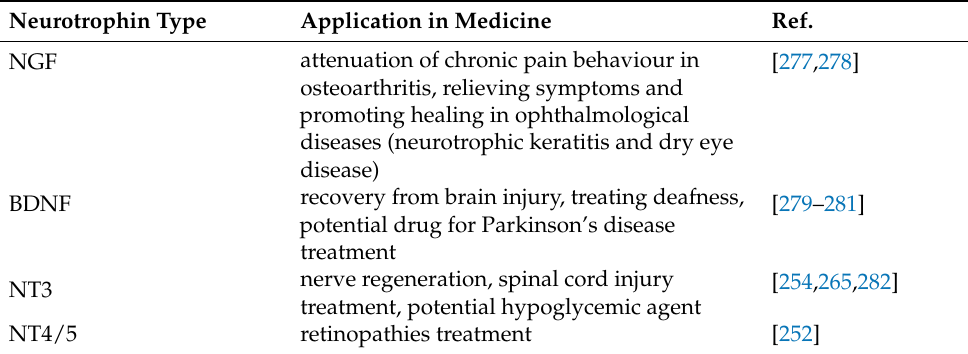
Table 4. The application of the neurotrophin family in medicine. Neurotrophin